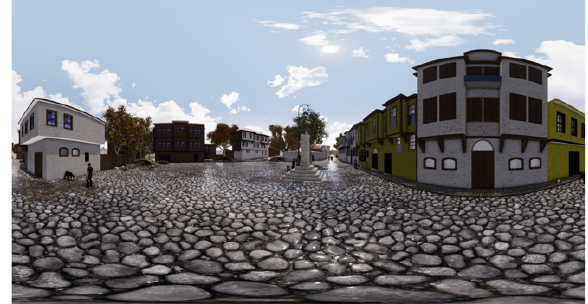
Figure 9. Panoramic image for VR mobile applications of